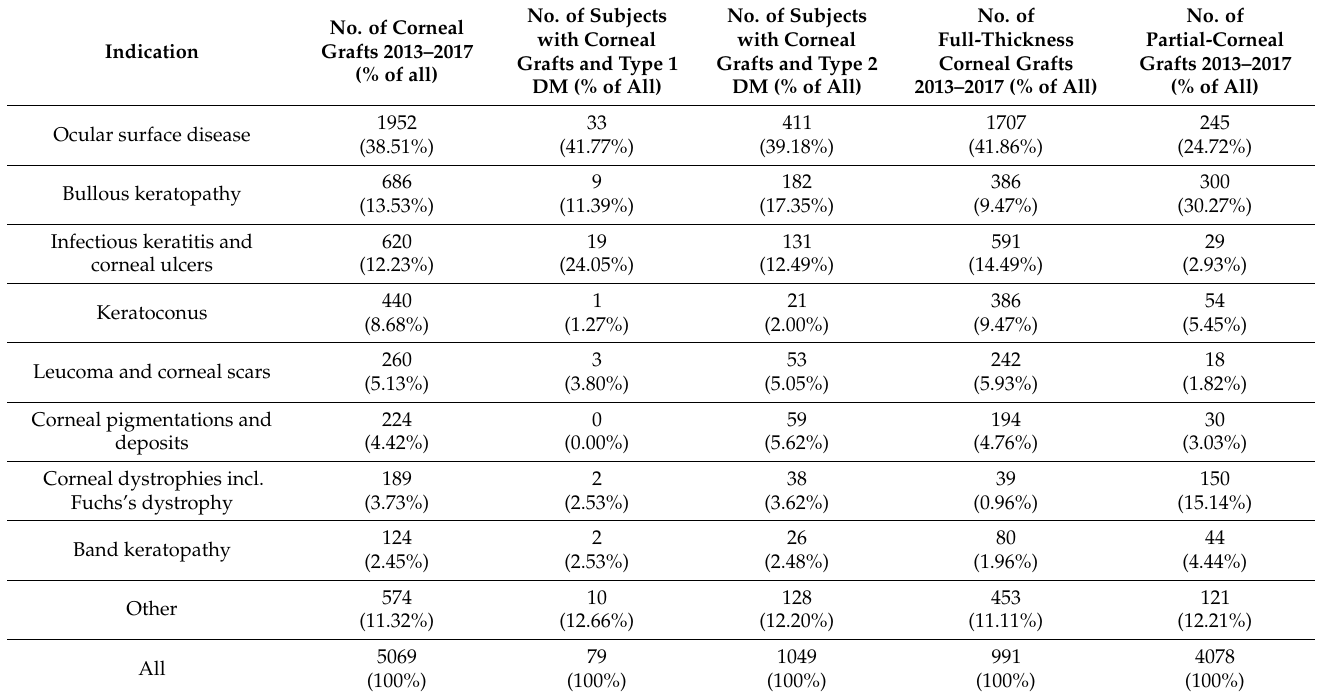
Figure 3. Number of full thickness and lamellar corneal grafts in Poland during 2013–2017. Table 3. Indications for corneal grafts in Poland in the years